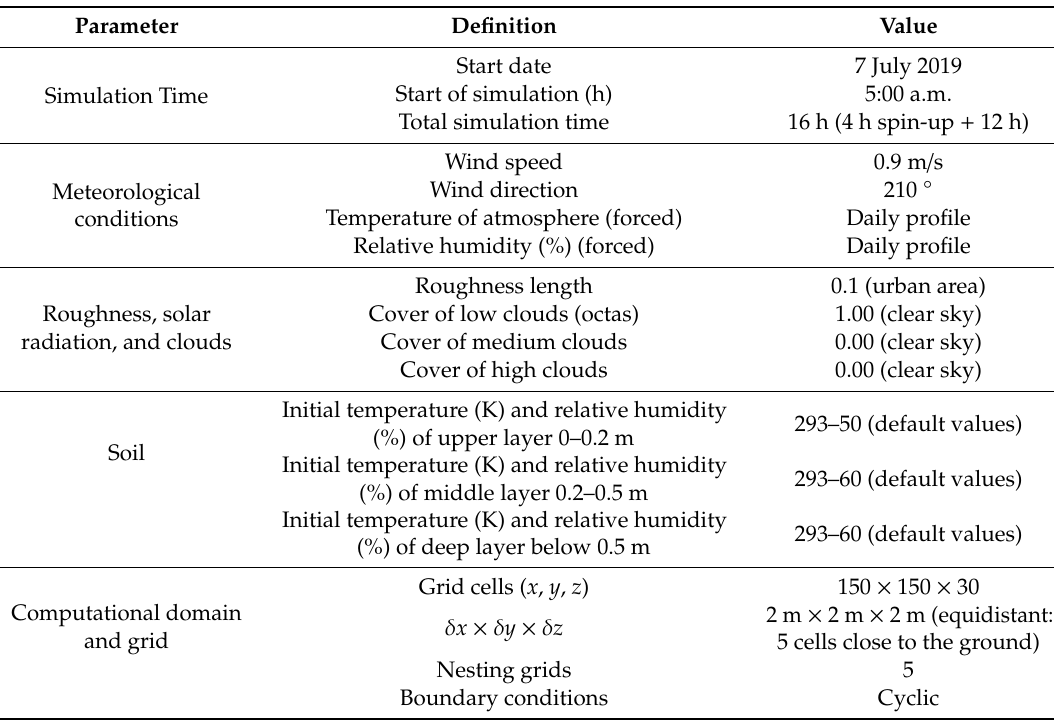
Table 1. Initial and boundary conditions used in ENVI-met